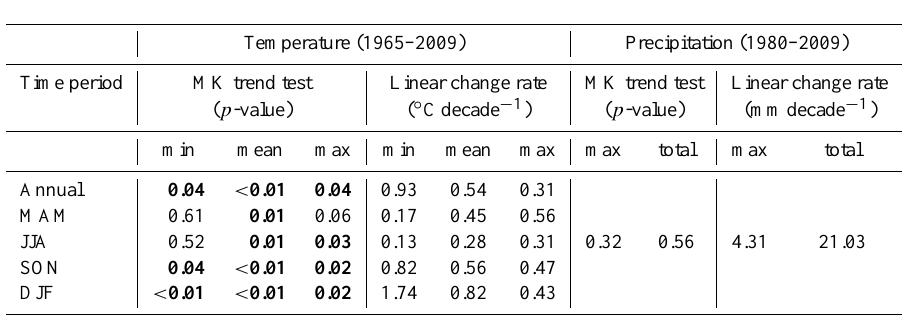
Table 3. Mann-Kendall (MK) trend test statistics on the maximum available time series data of annual and seasonal precipitation (1980– 2009) and temperature (1965–2009) for the Tarfala catchment. Trend significance of the MK trend test is indicated by the 2-sided p -value and trends significant at the 5% level are highlighted in bold. Linear change rates and the type of change (i.e., increasing (positive values), decreasing (negative values)) were estimated from the slope of a linear regression fitted to the data.